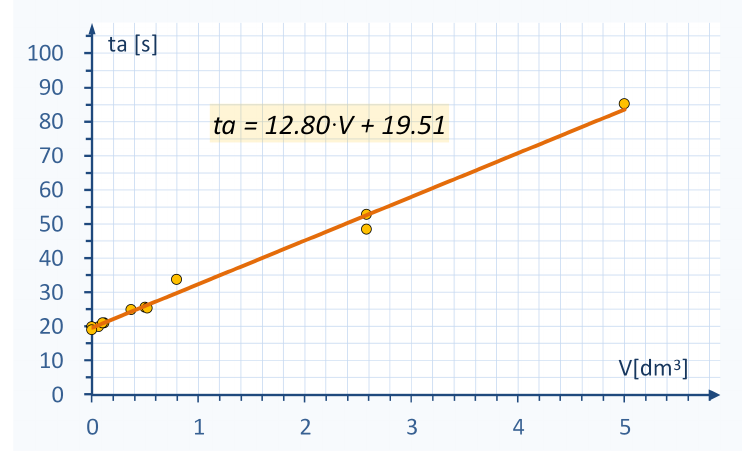
Figure 21. The overall tuning time versus the volume of the actuator